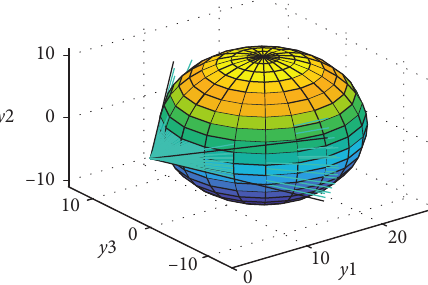
Figure 6: Tridimensional view of the obstacle at the distance of 1.35m by the AMR’s 3D lidar.